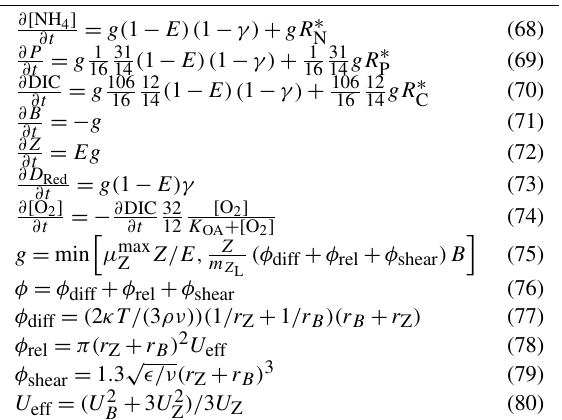
Table 13. Equations for zooplankton grazing. The terms represent Table 14. Equations for zooplankton carnivory, representing large a predator Z consuming a phytoplankton B . (1) If the zooplankton zooplankton Z L consuming small zooplankton Z S . The parameters diet contains multiple phytoplankton classes, and grazing is prey values and symbols are given in Tables 11 and saturated, then phytoplankton loss must be reduced to account for the saturation by other types of microalgae. (2) Z is the number of m Z individual zooplankton. (3) Phytoplankton pigment is lost to water column without being conserved. Chl a has a chemical formulae of C 55 H 72 O 5 N 4 Mg and a molecular weight of 893.49gmol − 1 . The uptake (and subsequent remineralisation) of molecules for chloro- phyll synthesis could make up a maximum (at C : Chl = 20) of ( 660 / 893 )/ 20 and ( 56 / 893 )/ 20 × ( 16 / 106 ) × ( 14 / 12 )) , or ∼ 4% and ∼ 2% of the exchange of C and N between the cell and water column, and will cancel out over the lifetime of a cell. Thus, the error in ignoring chlorophyll loss to the water column is small. ∂ [ NH 4 ] ∂t